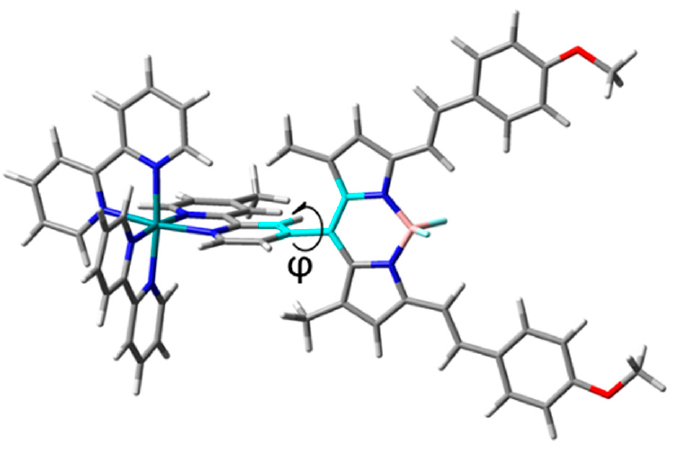
Figure 3. Optimised structure of the Ru-BDP conjugate.